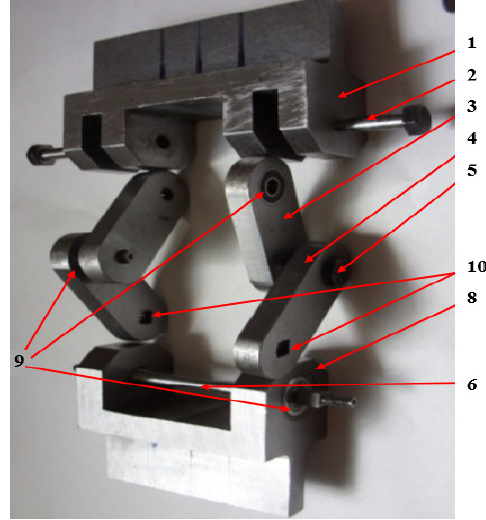
Figure 2. Device components and the sample.